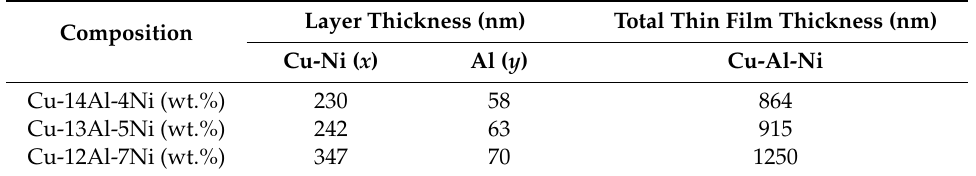
Table 1. Thickness values of the sputtered multilayers before quenching. The top and bottom Cu–Ni layers have half the thickness of the layers in between.